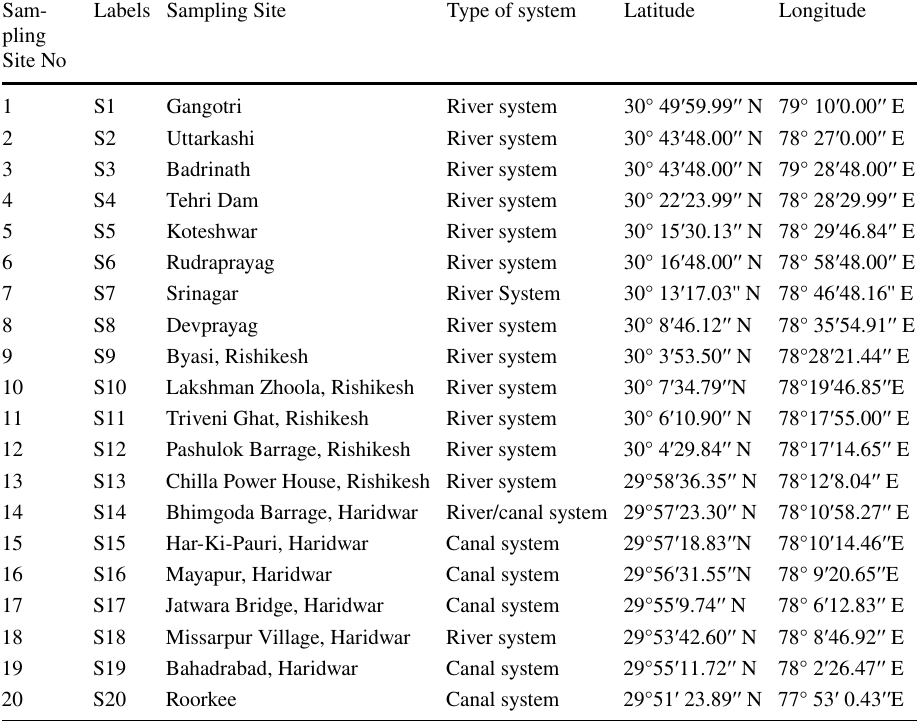
Table 1 Details of Sampling Site along Ganga River system with their geo-coordinated